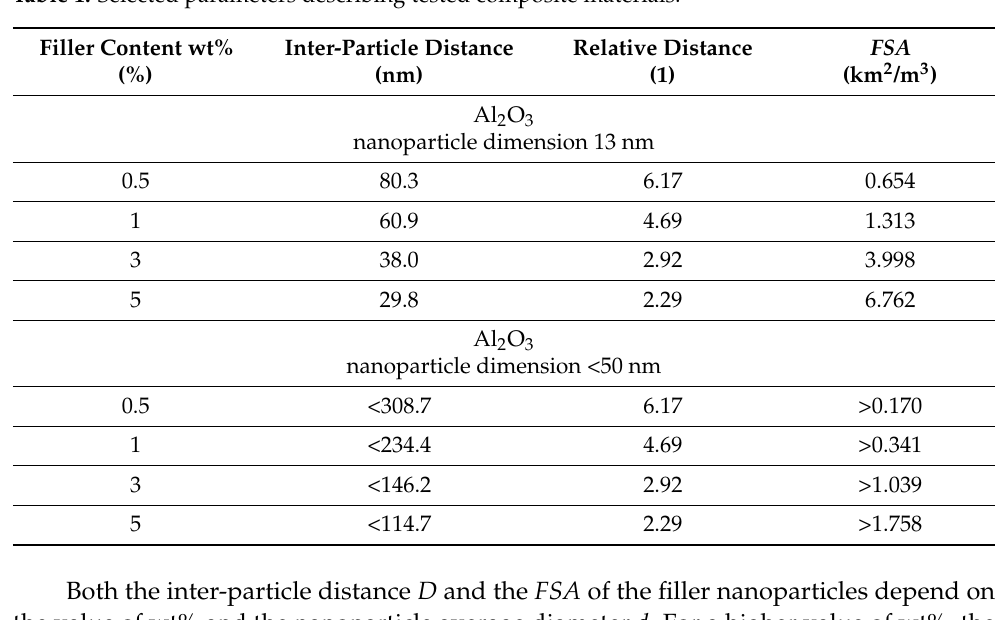
Table 1. Selected parameters describing tested composite